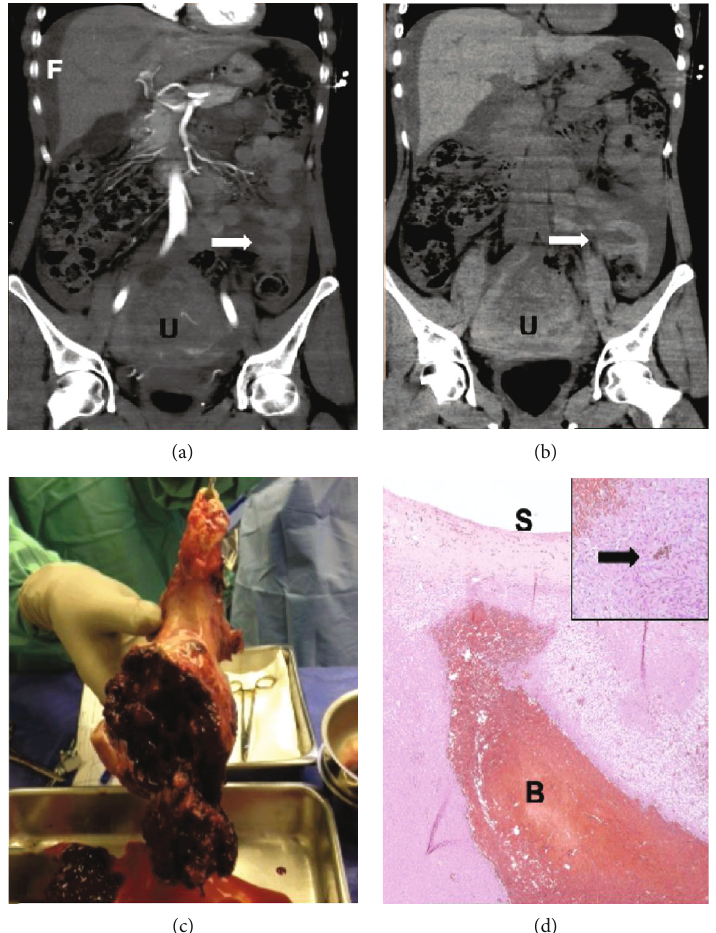
Figure 1: (a) Contrast-enhanced CT image with large volume hemoperitoneum (FF) and an enlarged uterus secondary to a large enhancing fi broid (UT). Sentinel blood clot in the pelvis with same enhancement as bowel loops nearby (arrow). (b) Noncontrast CT image of the retracted sentinel blood clot measuring 60 Houns fi eld units (arrow). (c) Surgical specimen of the cervix and the uterus with a ruptured mass on the posterior aspect. (d) Highly cellular leiomyoma with blood (BL) tracking to the serosal surface (SS) and hemosiderin-laden macrophages (inset). Hematoxylin and eosin stain at high power magni fi